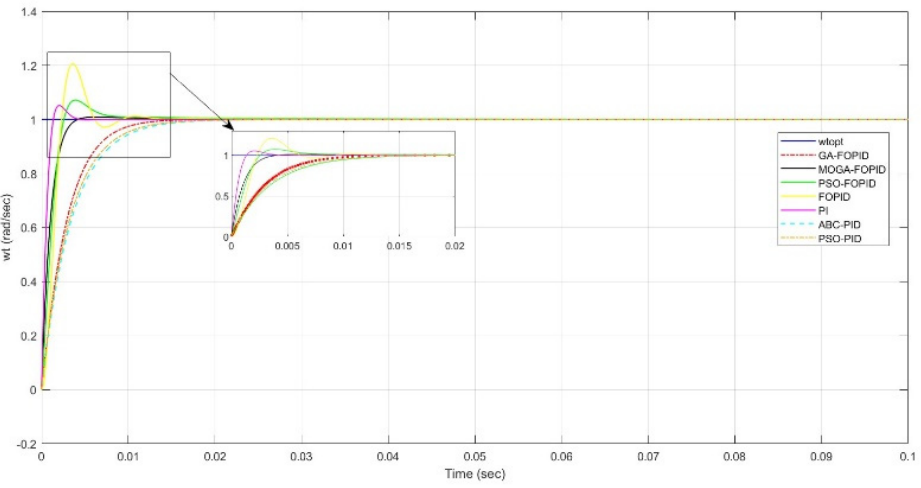
Figure 4. The speed of the wind turbine model for a step reference.